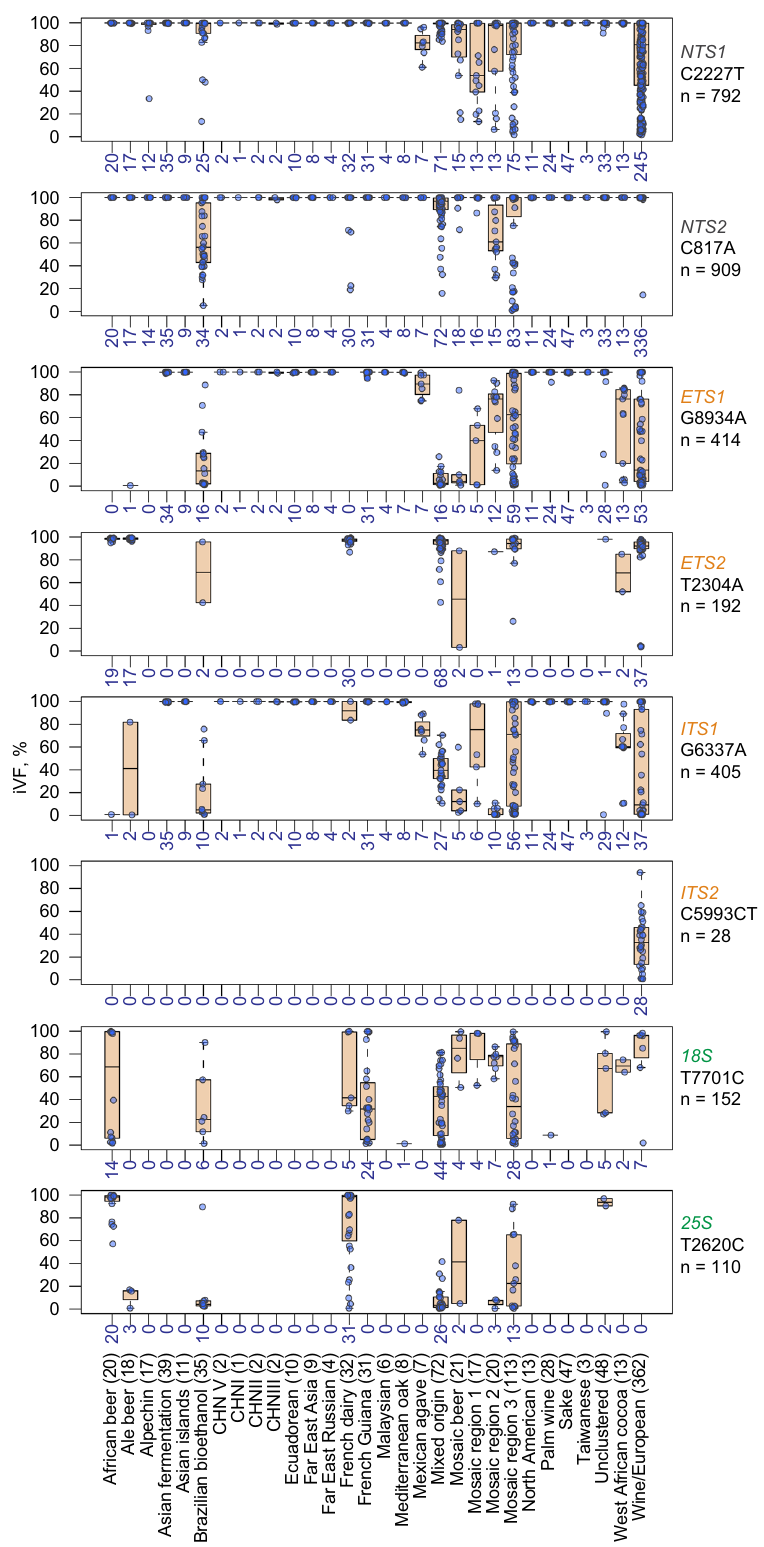
Fig. 4 | Box plot distribution of the topmost abundant rDNA variants in each rDNAelementacrossclades. Numbersindicateboththenumberofisolateswitha variantpercladeandthenumberofiVFPsofaspeci fi cvariant,sinceoneisolatecan